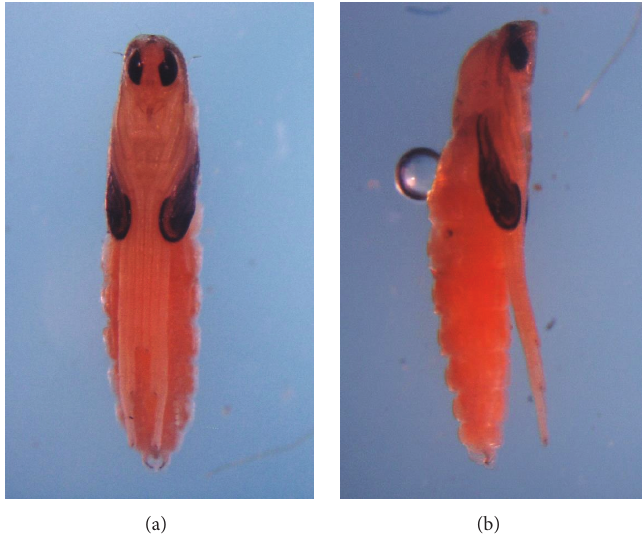
Figure 20: Late stage exarate pupa of L. donacis , ventral and side views.